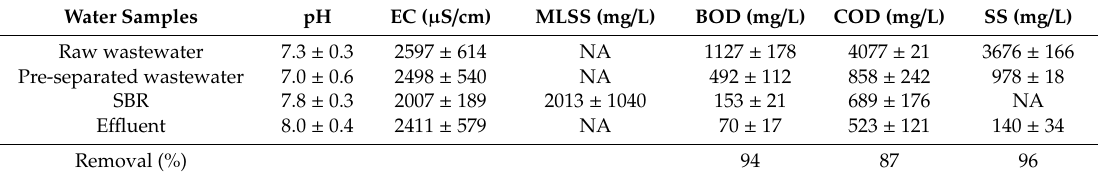
Table 3. Overall analytical chemical data of the wastewater quality indexes in water samples (n = 201).